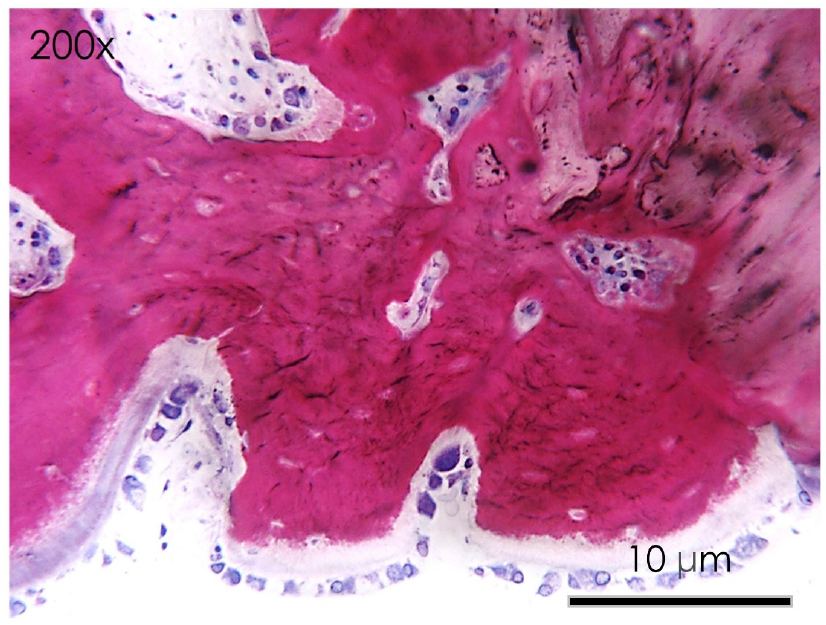
Figure 8. APIGENIN GROUP. Detail at higher magnification of the histological section of the calvaria bone specimens (200 × ). An active process of bone remodeling of the osteoid matrix was evident. In the resveratrol group no fibrous tissue was observed at the level of the newly formed bone surfaces compared to the control group (Figures 9 and 10). Newly formed bone was found in close contact with the calvarial defect margins with wide bone trabeculae and large osteocyte lacunae (Figure 10). The osteoblasts were actively secreting the osteoid matrix that, in some areas, was undergoing mineralization.